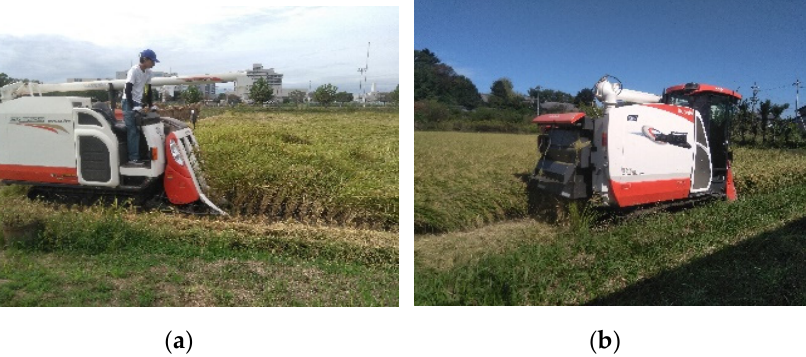
Figure 2. Mechanical harvesting scenario using ( a ) medium combine ( Model: ER329 ) and ( b ) large combine ( Model: ER6120 ). Table 1. Specifications of the medium and large combine harvesters.